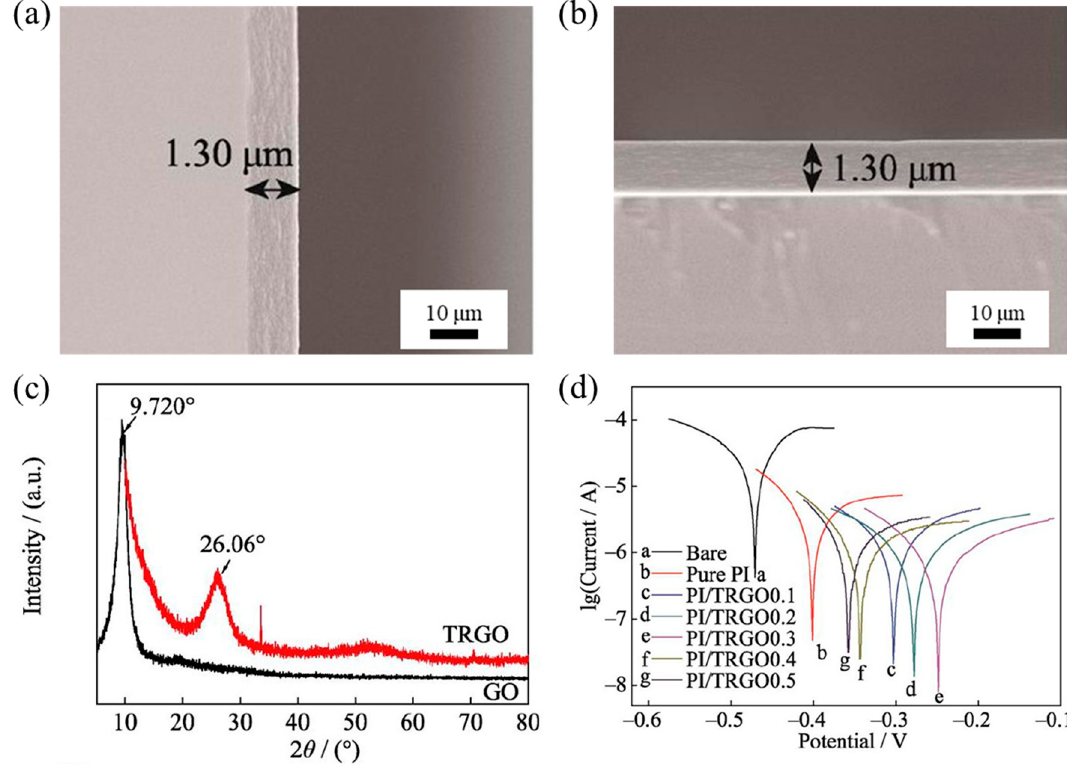
Figure 7. Photographs of the fractured surfaces of ( a ) the neat PI and ( b ) the TRGO0.1/PI coatings, ( c ) XRD patterns of GO and TRGO. ( d ) Tafel plots of the bare steel, pure PI, and TRGO/PI coatings [104].